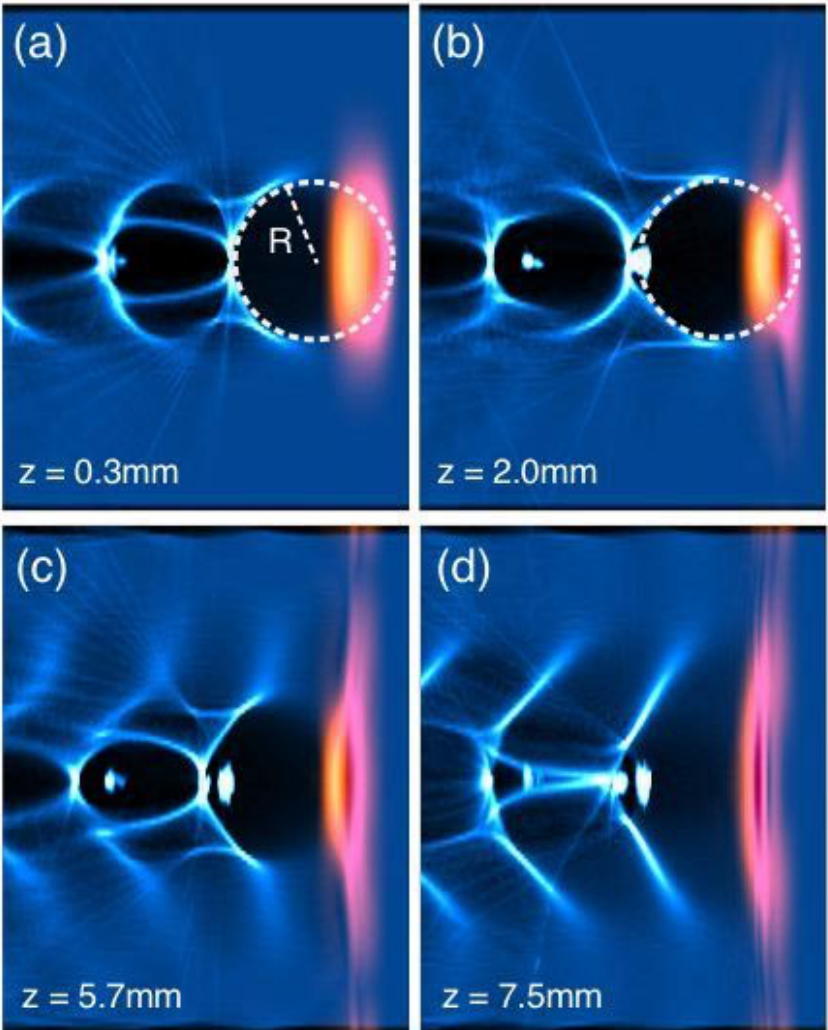
FIG. 1. (Color) A sequence of 2-dimensional slices (cid:4) x (cid:2) z (cid:5) reveals the evolution of the accelerating structure (electron density, blue) and the laser pulse (orange). Each plot is a rectangular of size z (cid:3) 101 : 7 (cid:3) m (longitudinal direction, z ) and x (cid:3) 129 : 3 (cid:3) m (transverse direction, x ). A broken white circle is superimposed on each plot to show the shape of the blown-out region. When the front of the laser has propagated a distance (a) z (cid:3) 0 : 3 mm , the matched laser pulse has clearly excited a wakefield. Apart from some local modification due to beam loading effects, as seen in (b) this wakefield remains robust even as the laser beam propagates though the plasma a distance of 7.5 mm [as seen in (c) and (d)] or 5 Rayleigh lengths. After the laser beam has propagated 2 mm [as seen in (b)] into the plasma, one can clearly see self-trapped electrons in the first accelerating bucket. The radial and longitudinal localization of the self- trapped bunch is evident in part (c). After 7.5 mm the acceleration process terminates as the depleted laser pulse starts